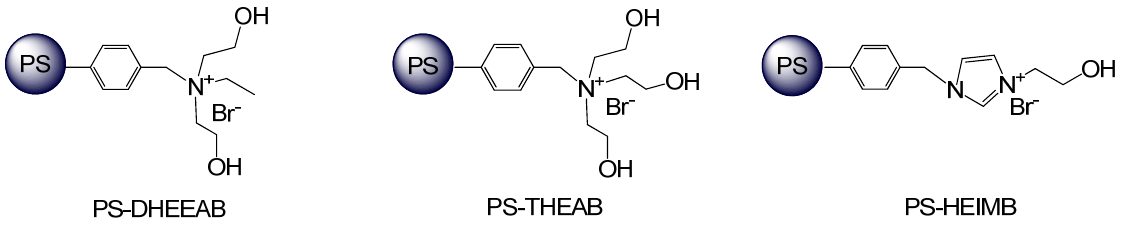
Table 11. Synthesis of PC catalyzed by PS supported diethanolamine based ILs catalyst a [95]. Entry Catalyst Conversion b (%) Selectivity b (%) 1 DHEDEAB 86 99 2 PS-DHEEAB 69 99 3 c PS-DHEEAB 92 99 4 d PS-DHEEAB 99 99 5 PS-THEAB 65 99 6 PS-HEIMB 52 99 7 PS-EIMB 35 99 8 e PS-DHEEAB 91 99 9 f PS-DHEEAB 91 99 10 g PS-DHEEAB 92 99 11 h PS-DHEEAB 91